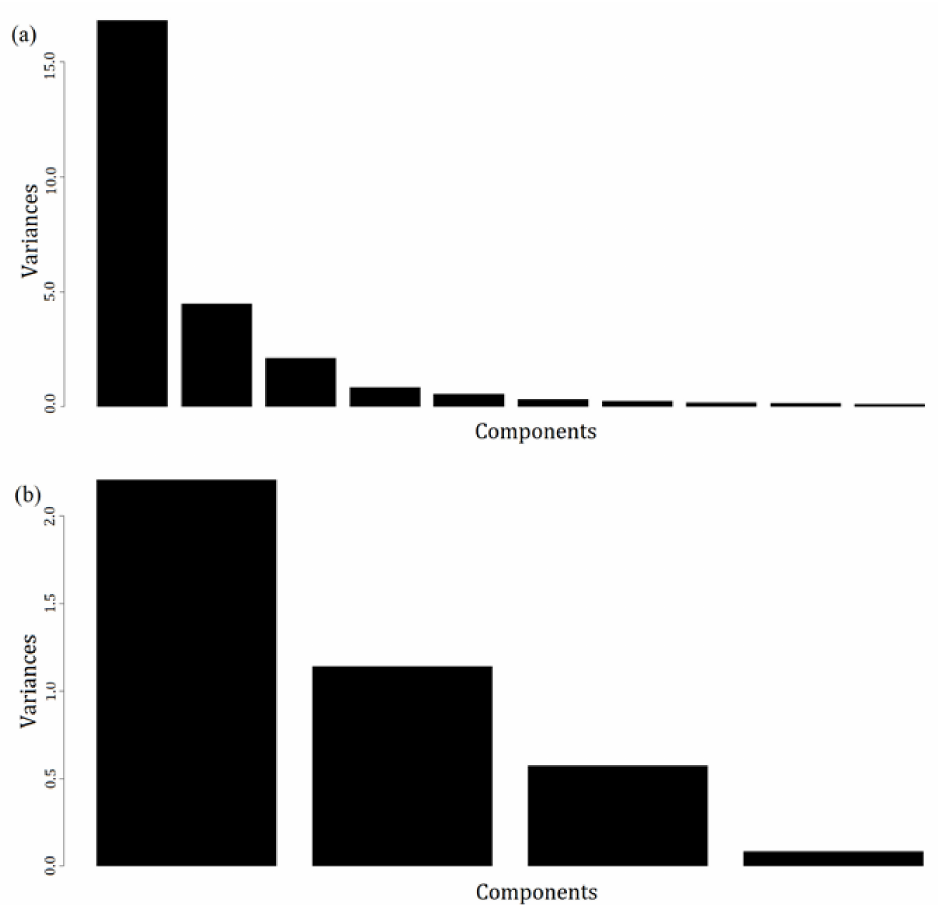
Figure 2. Scree plot that shows the variance in the principal components for ( a ) 26 climatic variables in the Atlas Bioclim á tico de Chile (Uribe et al., 2012) [3] and ( b ) four topographic variables obtained through a digital elevation model (DEM) in the Atacama